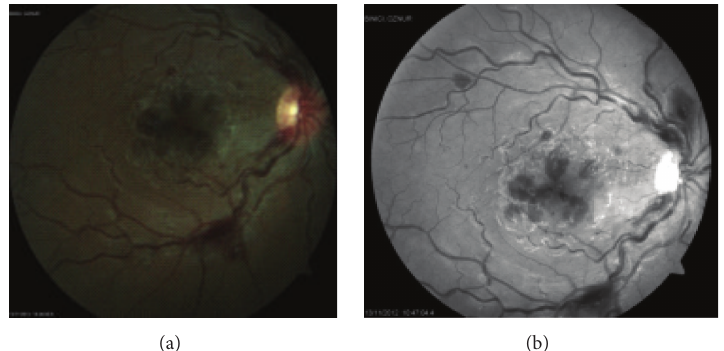
Figure 1: Initial examination of the right eye: (a) fundus photography; (b) red free fundus photography.